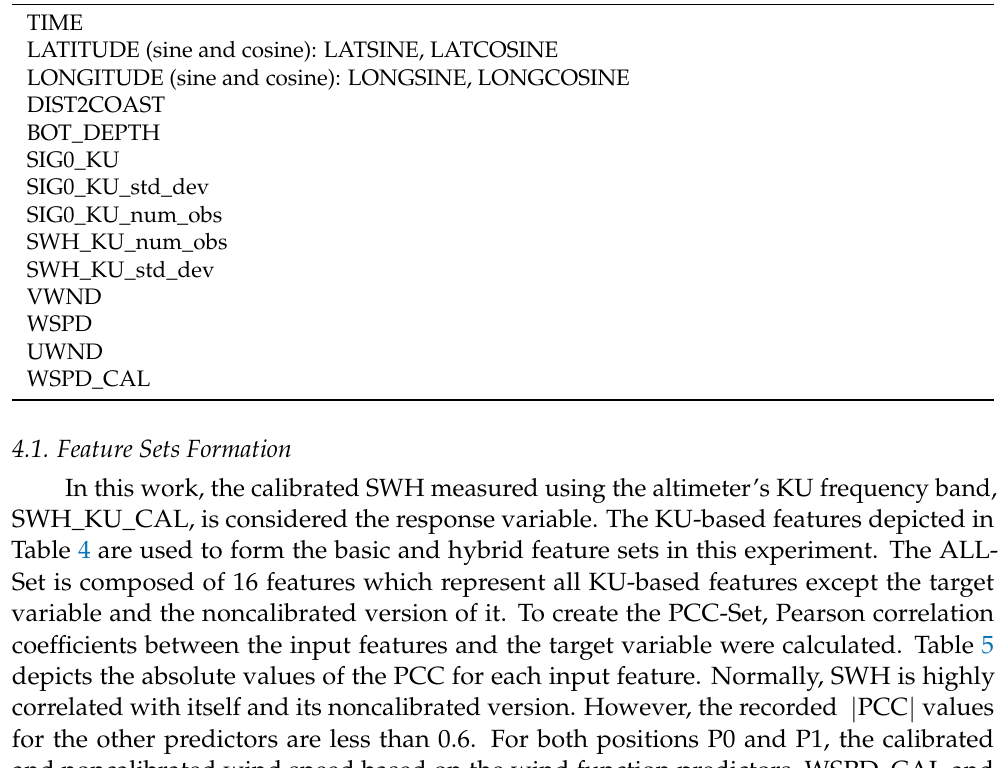
Table 4. KU-band-based features used for modeling KU-based SWH. KU-Band-Based